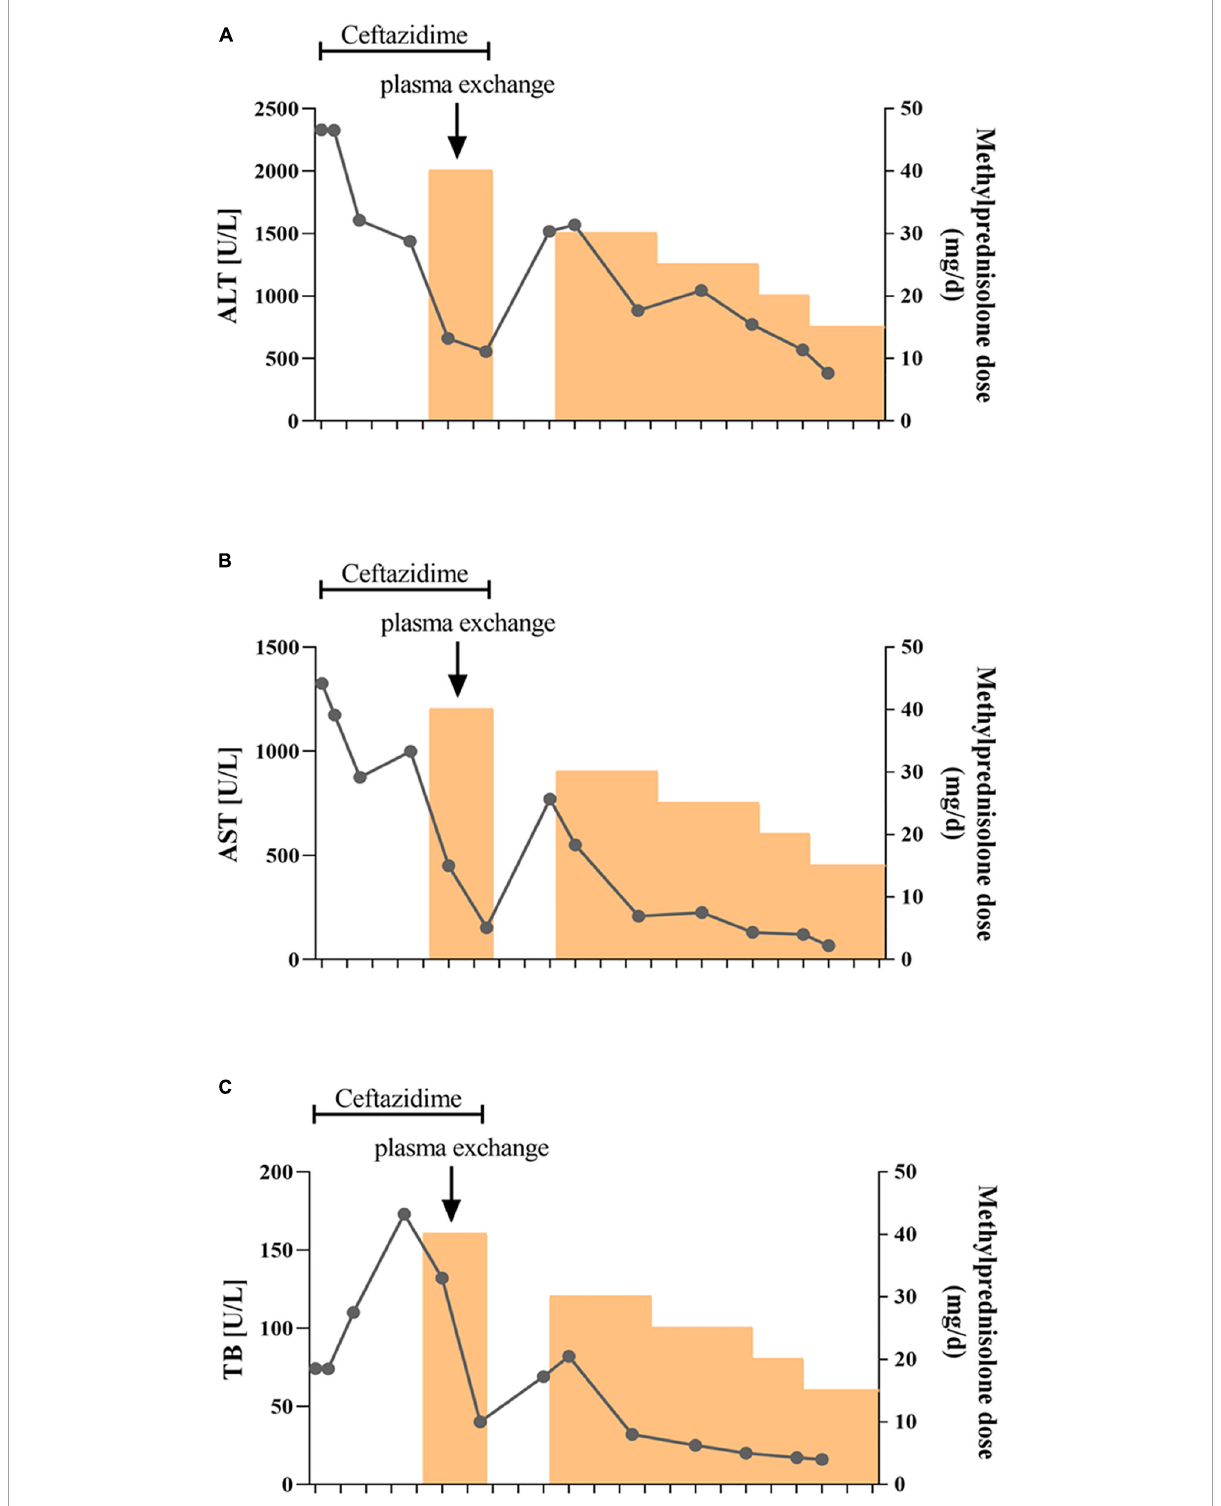
FIGURE4 Schematic diagram of the transaminase and bilirubin fluctuations during treatment. The alanine aminotransferase (A) , aspartate aminotransferase (B) , and total bilirubin (C) levels were tested every 3–5 days during treatment. Ceftazidime was used for the first two weeks followed by methylprednisolone treatment. The patient also received plasma exchange once due to rapid aggravation of